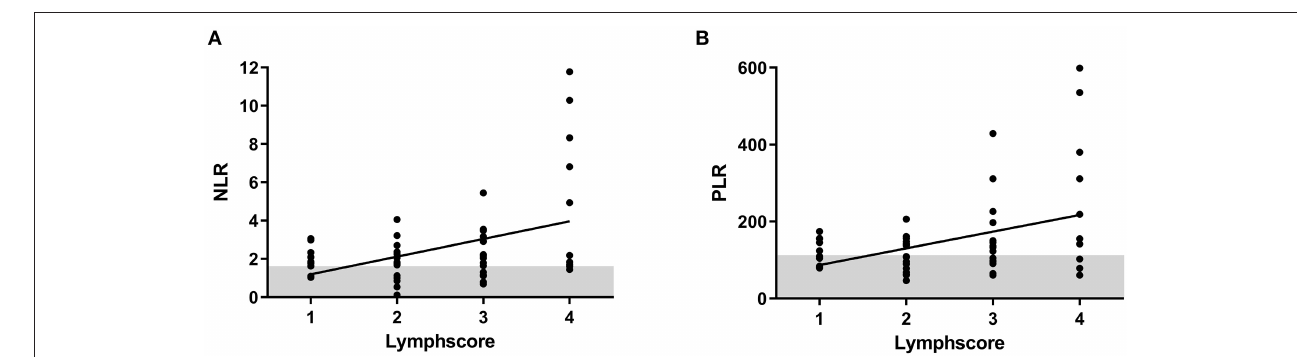
Frontiers in Pediatrics |